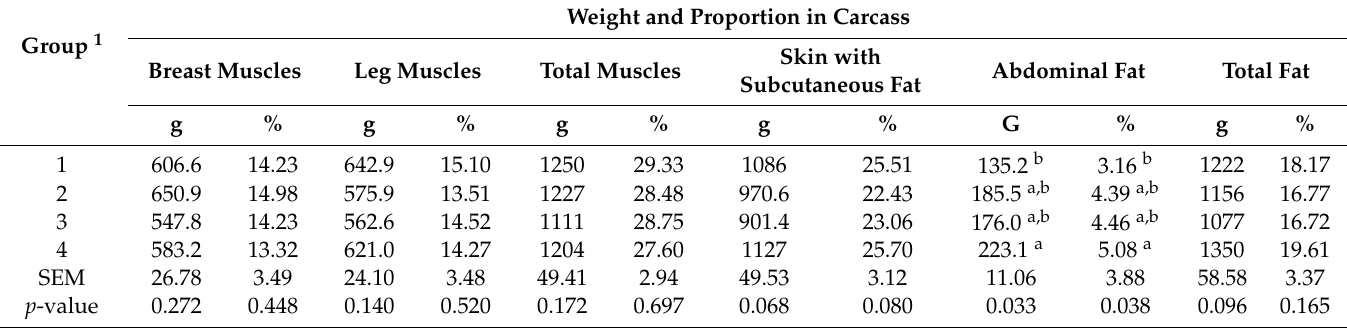
Table 6. Content of muscles and fat in 77-day-old broiler